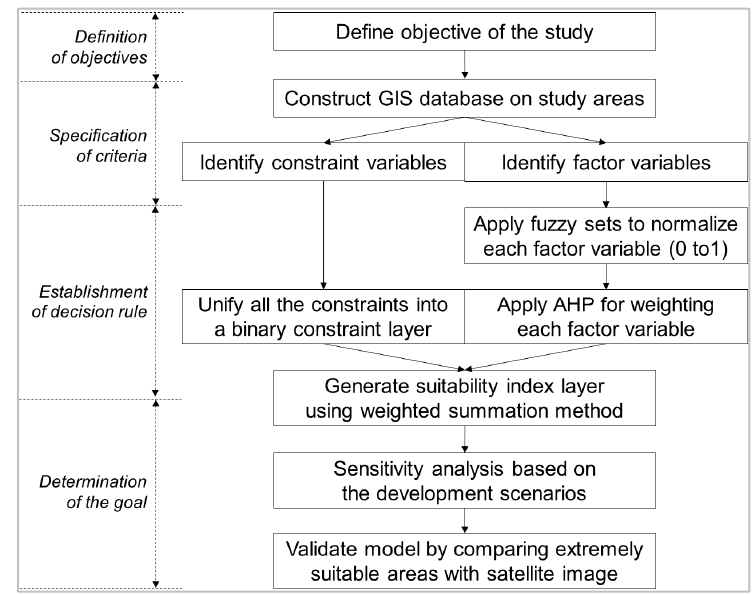
Figure 1. Flow chart of photovoltaic (PV) solar farm site suitability analysis model designed based on the four phases of multi ‐ criteria evaluation (MCE) process in a GIS environment.